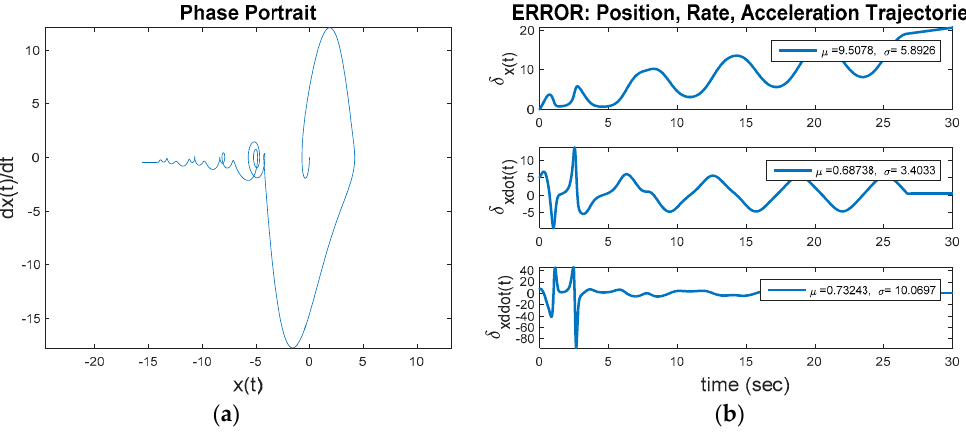
Figure 9. Commanding a desired trajectory as a circle of radius five using both idealized feedforward control and optimal LTI feedback control. ( a ) displays trajectory comparison, ( b ) trajectory.